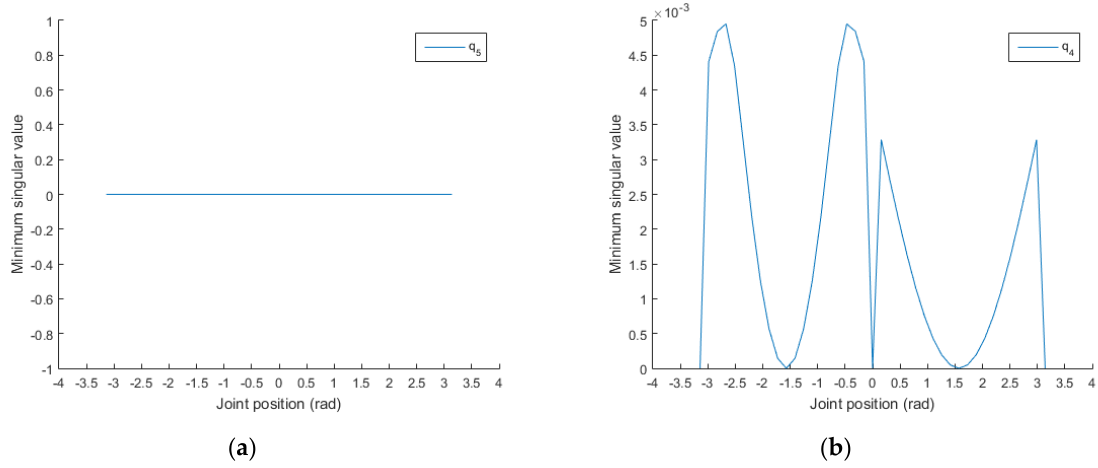
Figure 9. ( a ) Setting q 2 = q 3 = q 4 = 0, ± π rad, the distribution of the minimum singular value with the change in q 5 ; ( b ) setting q 2 = q 3 = q 5 = 0, ± π rad, the distribution of the minimum singular value with the change in q 4 . Figures 7–9 show that when q 2 = q 3 = q 4 = 0, ± π ; q 2 = q 3 = 0 , ± π , and q 5 = ± π /2; q 4 = q 5 = 0 , ± π , singular configurations occur.